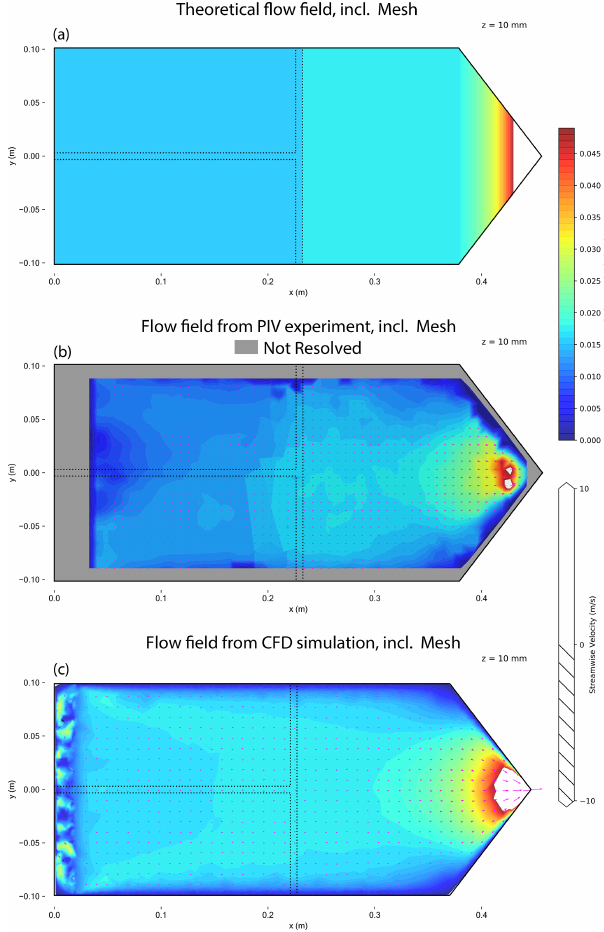
Figure A2. Contour plot of flow velocity magnitudes at a horizon- tal plane of the HINC cavity at mid-height. The chamber is set to T = 243K and S w = 1 . 04. Theoretical flow field (a) , flow field measured using PIV (b) and simulated flow field from CFD (c) . Arrows indicate flow direction; the hatching marks regions with re- versed flow. The dashed line represents a possible position of the injector.